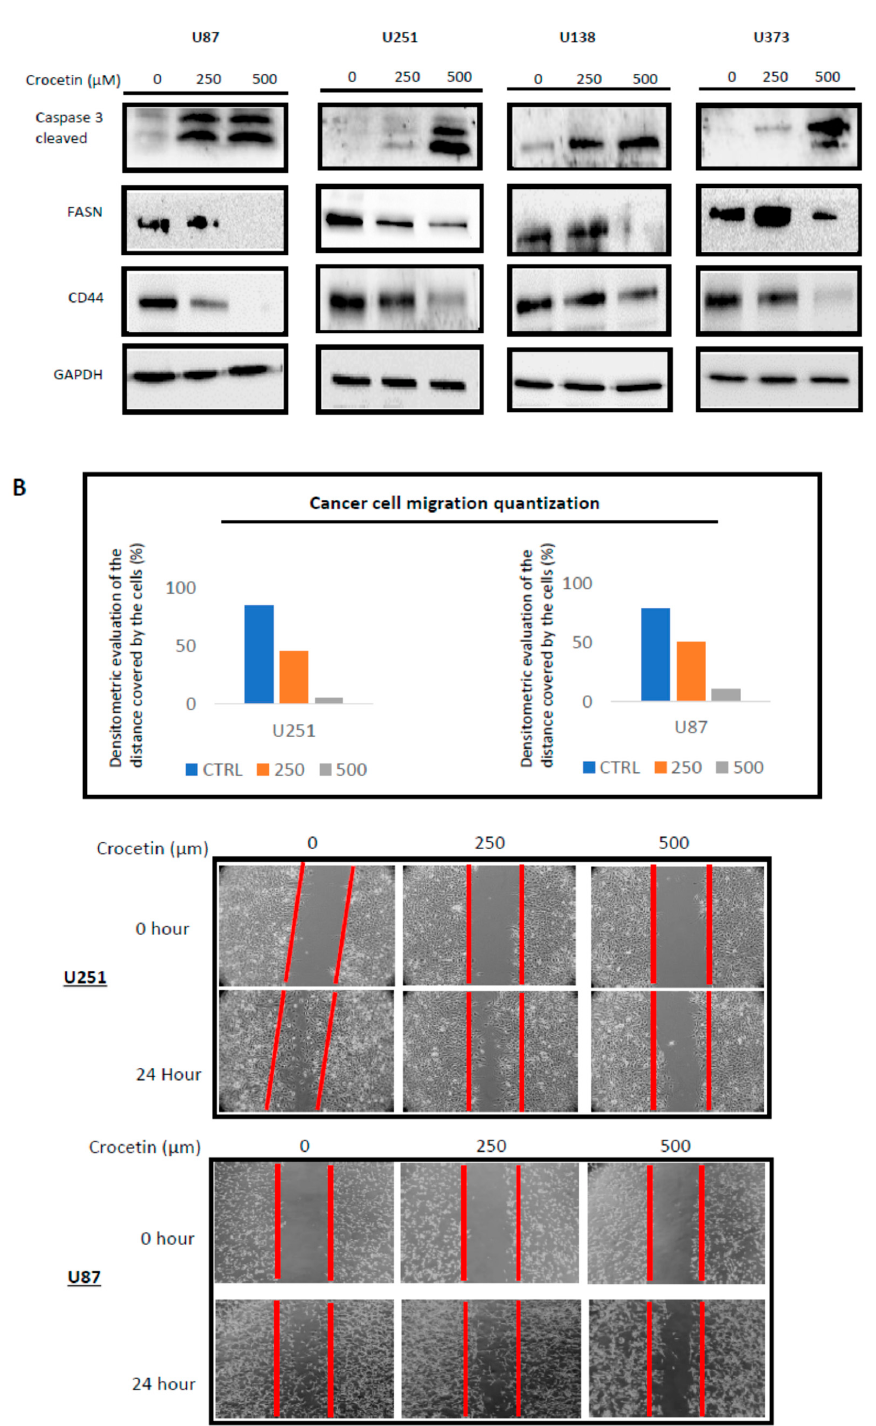
Figure 3. CCT inhibits the expression of FASN and CD44 proteins, thereby inducing cell apoptosis and reducing migratory capacity. ( A ) Western blot analyses of whole protein extracts harvested from treated (250 and 500 µ M CCT) and untreated GBM cell lines for CD44, FASN, and activated caspase 3, for normalized versus GAPDH. Lanes were loaded with 20 µ g of protein. ( B ) The wound-healing repair assay was performed on the U87MG and U251 cells. The images were acquired at T0 and T24 h. Quantization was performed by Image J software, as indicated in panel